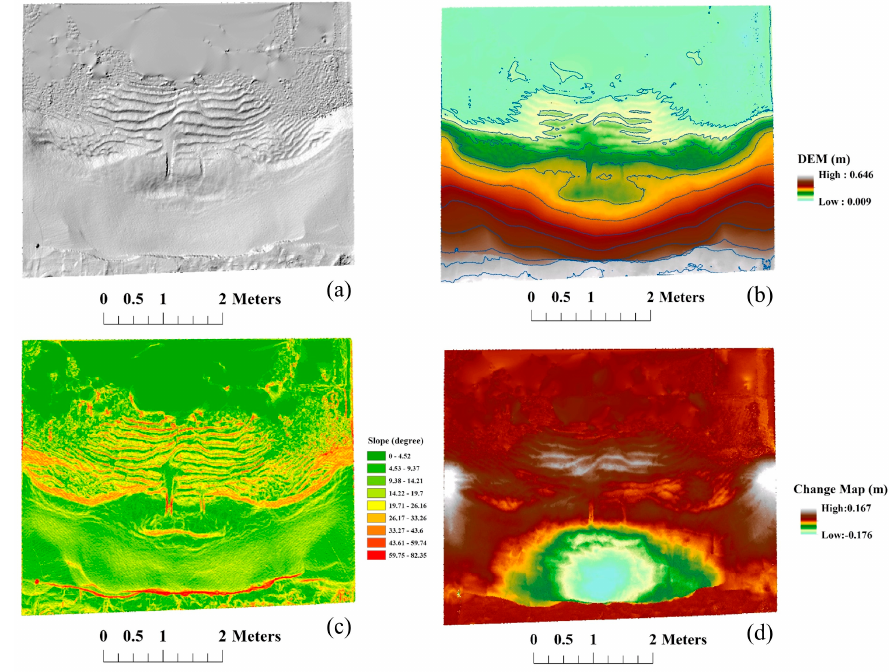
Figure 3. ( a ) Hill-shaded relief map, ( b ) contour map (5 cm intervals) overlaid on DEM, ( c ) slope map and ( d ) map of elevation change.